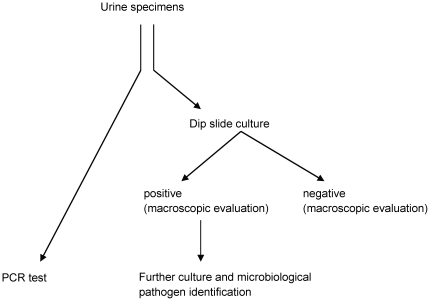
Workflow of the urine specimens to the different tests.Samples were classified as positive and count as one in case of mono or multiple infection.